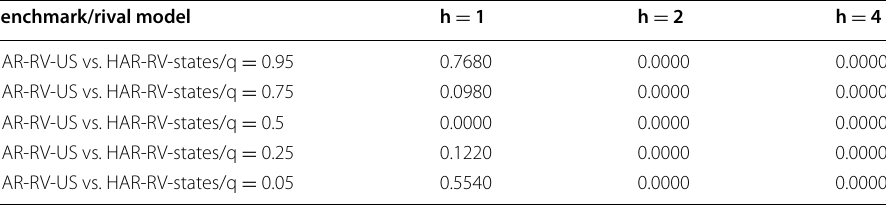
Table 2 Results of permutation